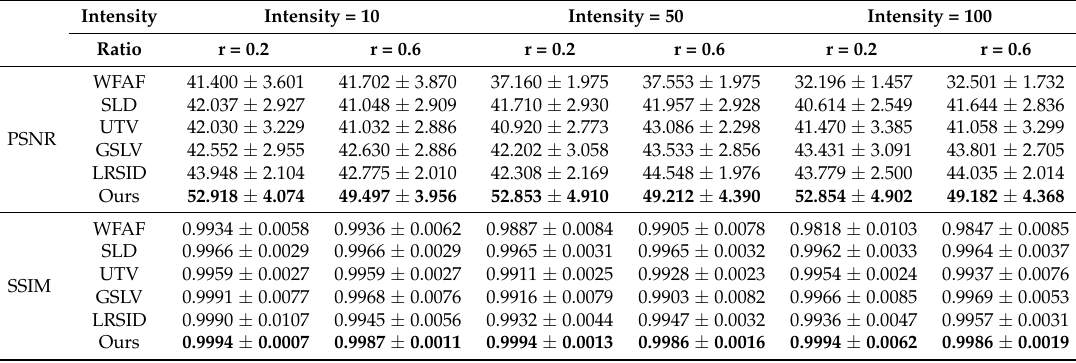
Table 2. The mean value of PSNR and SSIM of 32 images with periodic noise.